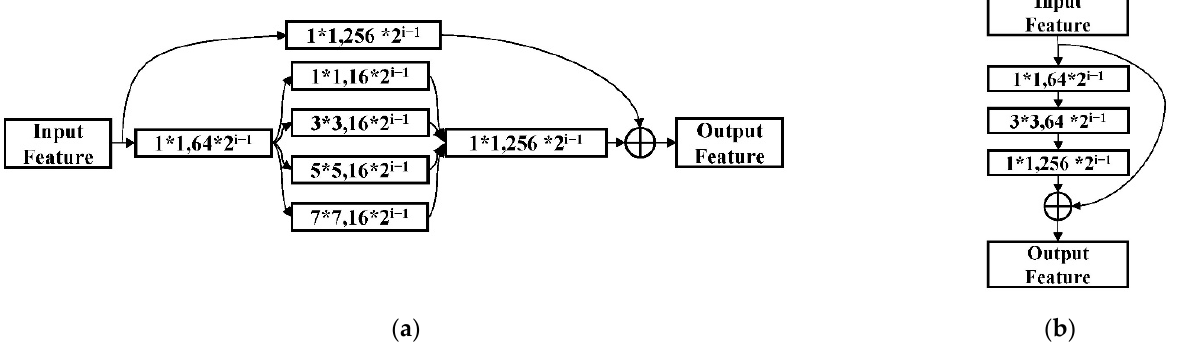
Figure 5. Structures of the modules in the encoder. ( a ) Conv_block. ( b ) Identity_block. i: The convolution stage.